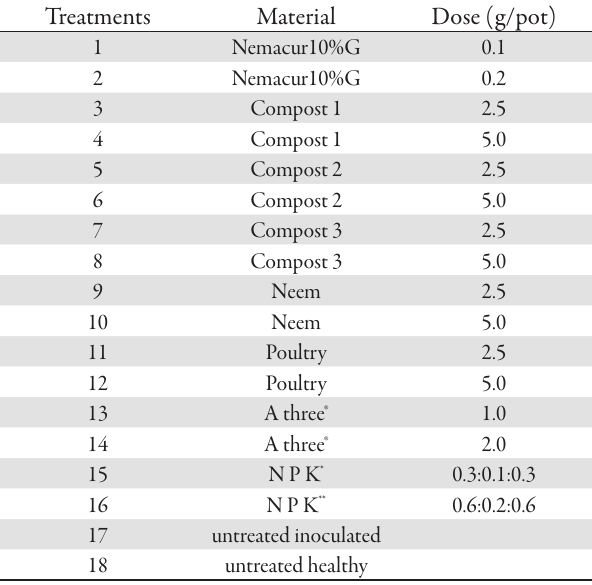
Tab. 1. The organic and inorganic fertilizers treatments